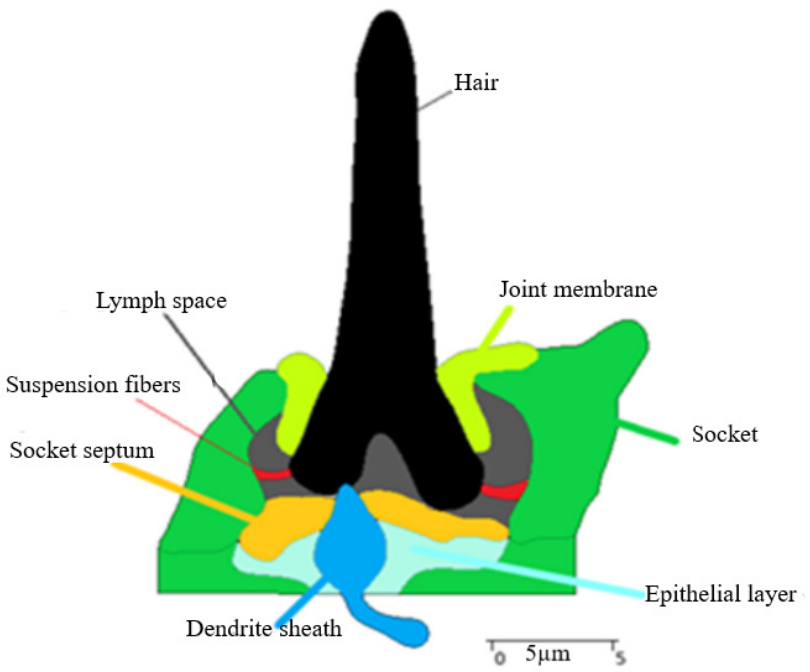
Figure 4. Section view of the trichoid sensilla from AMIRA software consists of the hair, socket, epithelial layer, dendrite sheath, lymph space, socket septum, suspension fibers, and joint membrane.